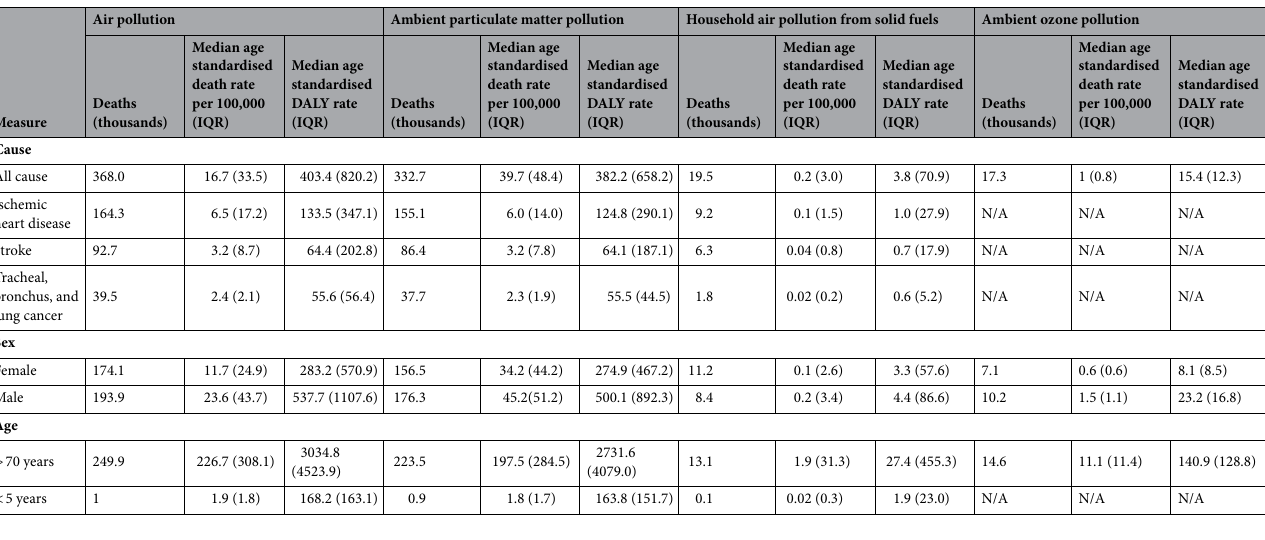
Table 1. Deaths, age-standardised death rates, and DALYs rate attributable to air pollution in Europe in 2019. IQR, interquartile range. Certain data for ozone marked with "N/A" was not available in GDB 2019.